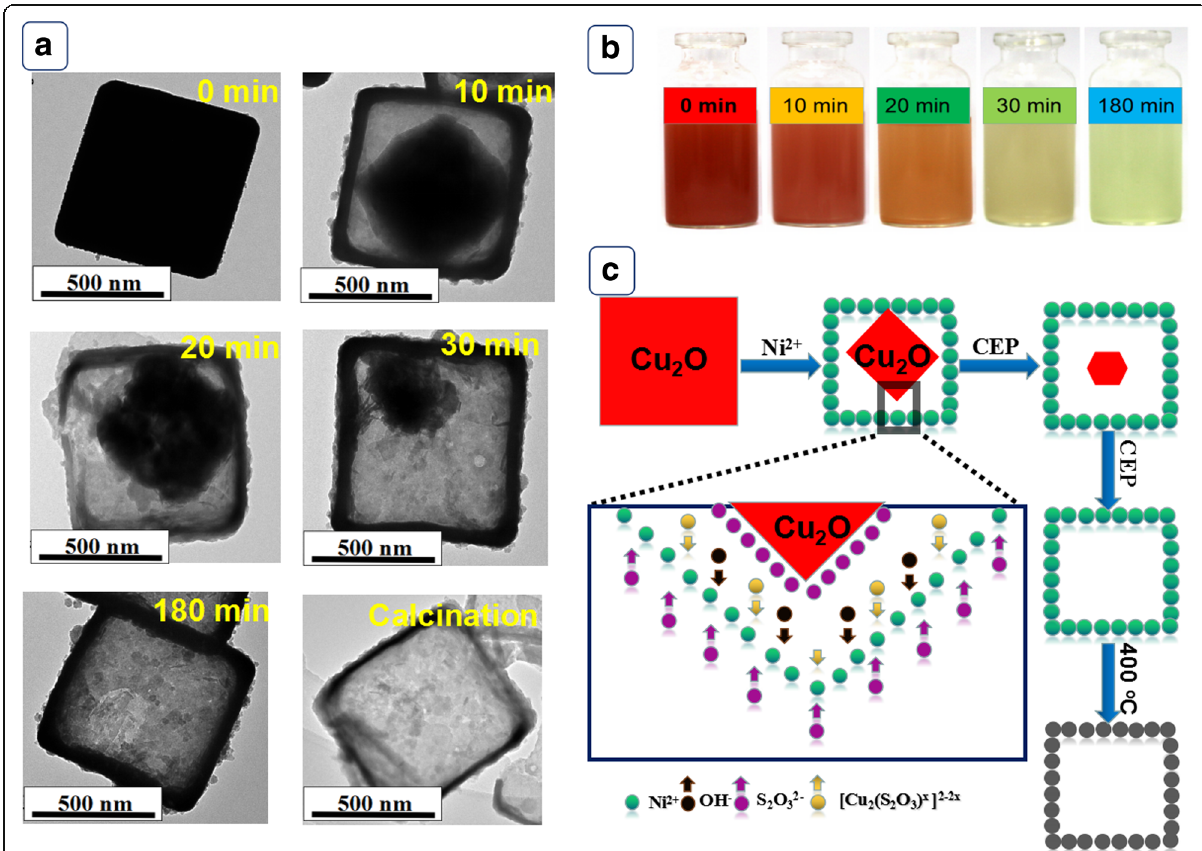
Fig. 3 a TEM images of the products monitored at different reaction times. b Optical photographs of the suspension at different reaction time after addition of etchant. c Schematic illustration of the proposed growth mechanism of NiO HPA